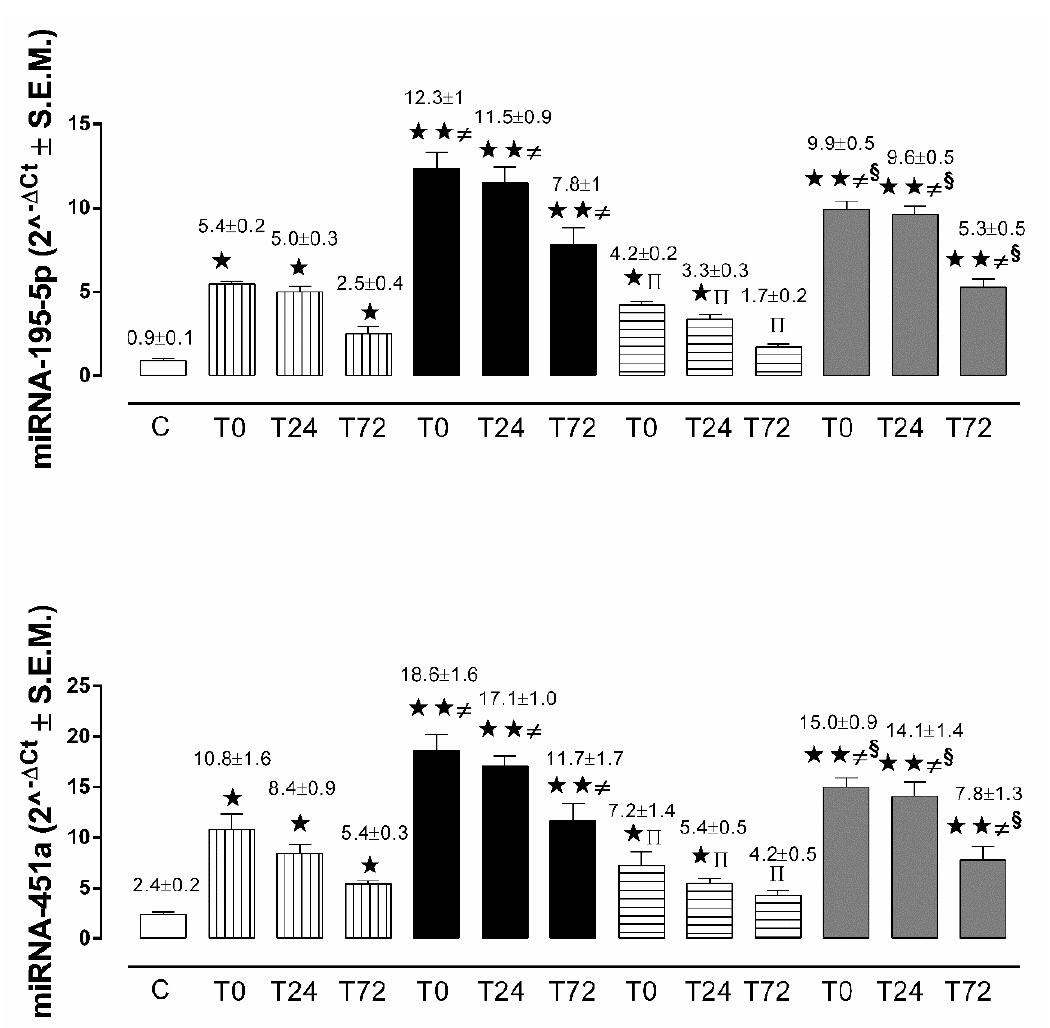
Figure 1. Micro-RNA (miRNA)-195-5p and miRNA-451a expression levels as mean of 2^ - Δ Ct ± S.E.M. in control subjects (white column), in non-diabetic AIS patients (vertical line column), in non-diabetic TIA patients (horizontal line column), in diabetic AIS patients (black column), and in diabetic TIA patients (grey column).